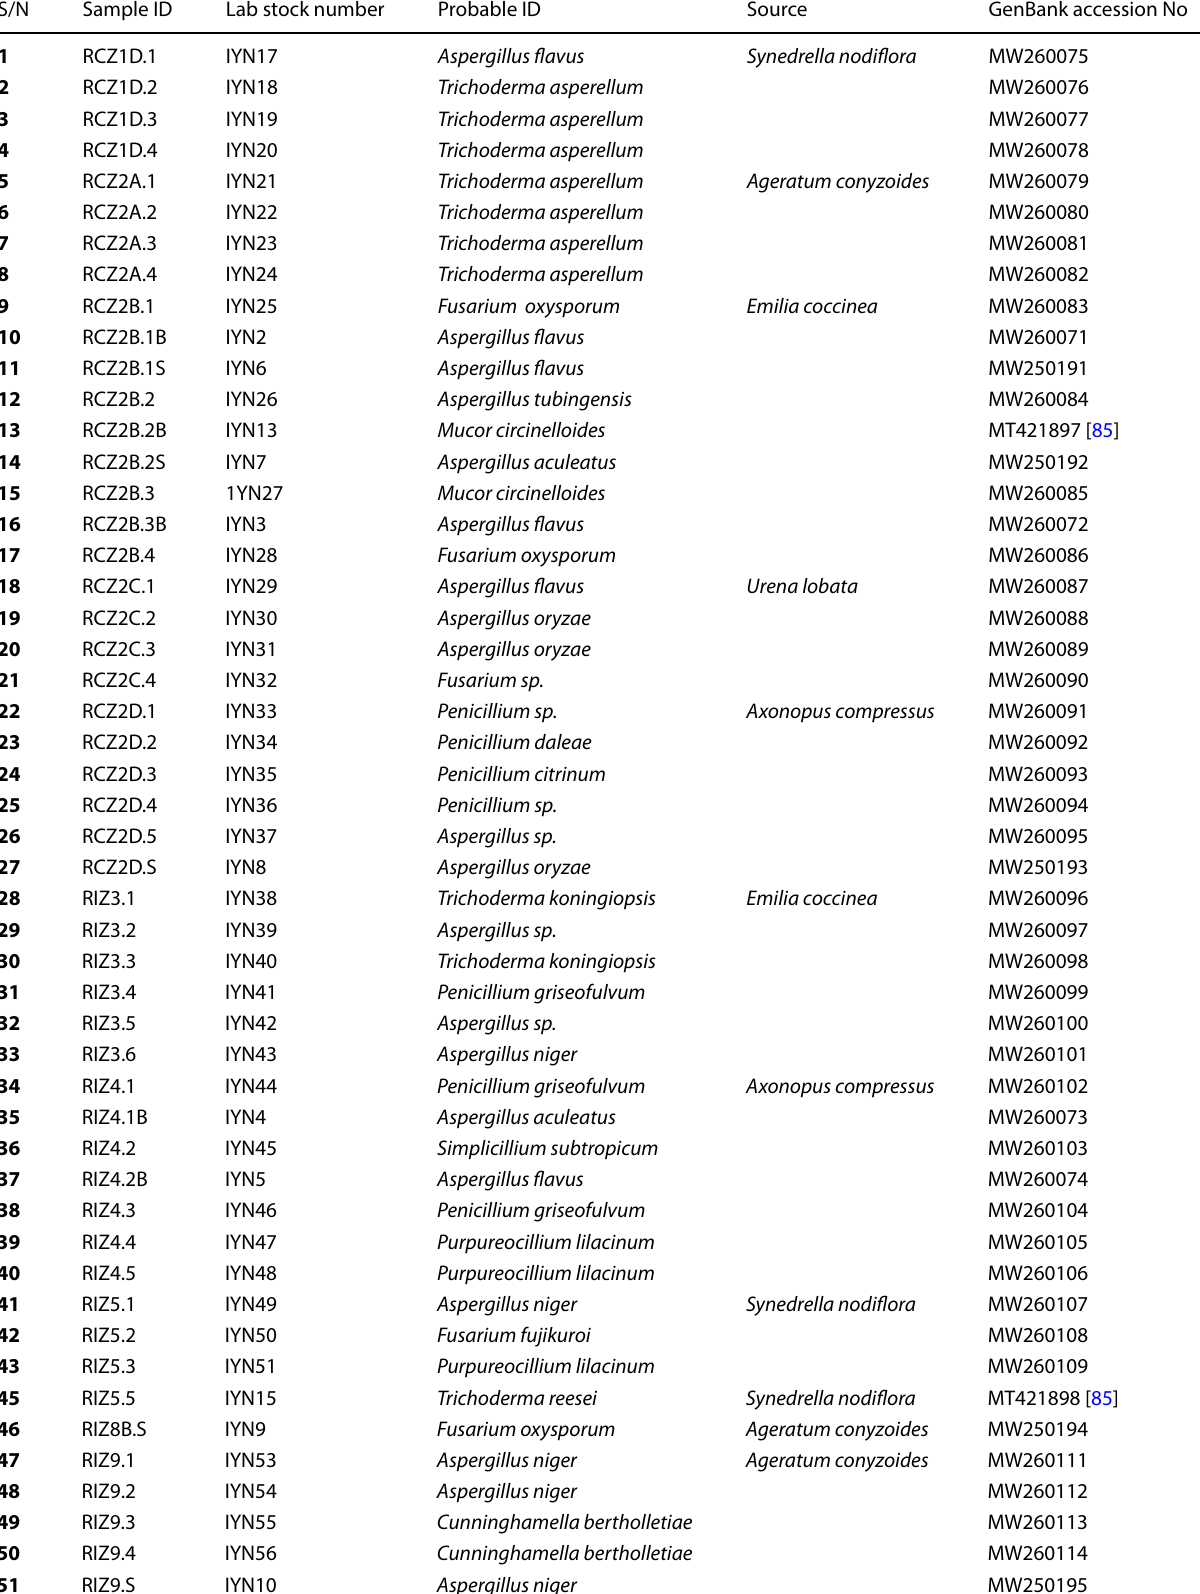
Table 1 Fungal species isolated and GenBank accession numbers for their partial ITS